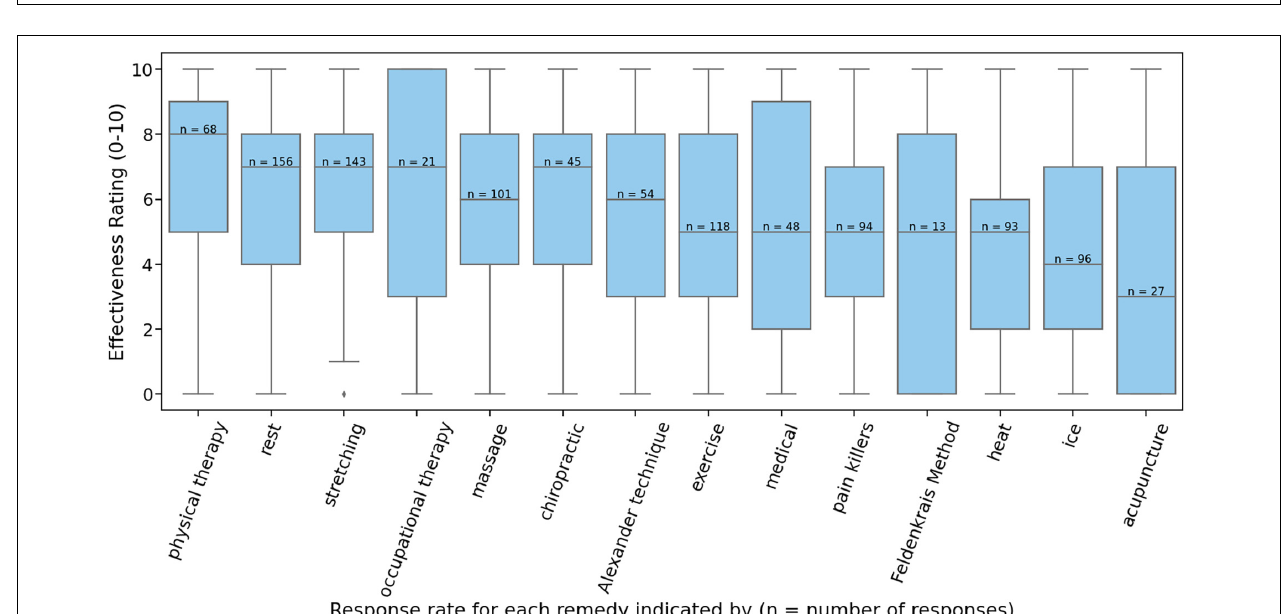
FIGURE 8 | PRMD average maximum severity (scale of 1 to 10) by weekly playing hours.